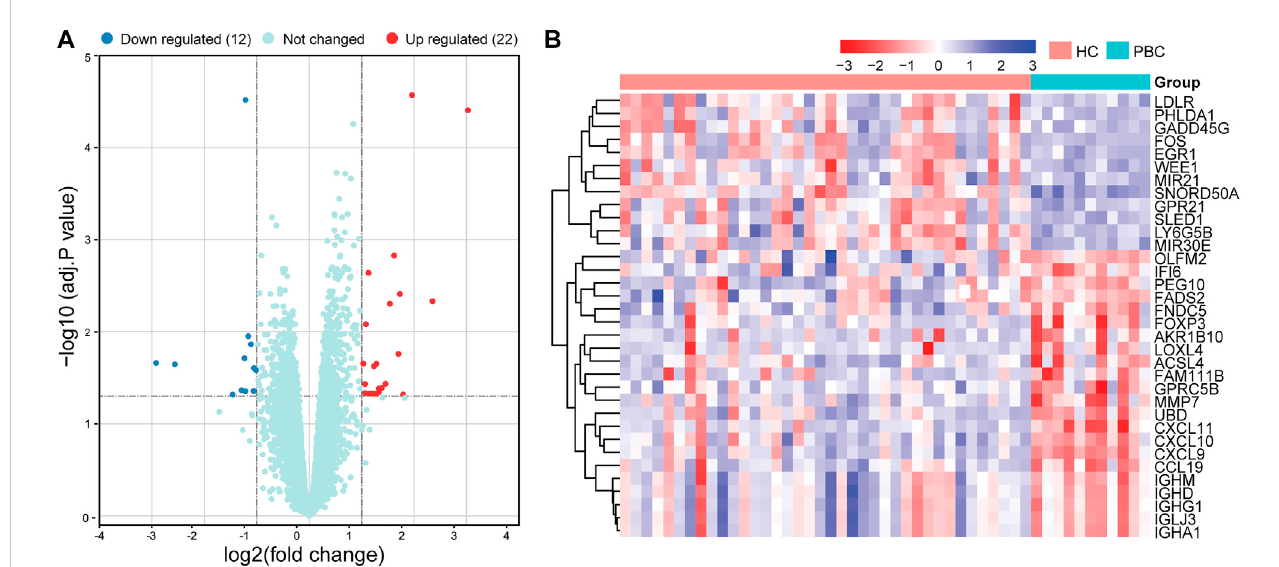
FIGURE 2 Volcano plot and heatmap of DEGs in the datasets. (A) Volcano map of all DEGs in GSE61260 analyzed using the limma package in R. Adjusted p -value < .05 and | log2 FC | ≥ 1 were considered threshold values of signi fi cant DEGs. (B) Heatmap of DEGs, including 22 up- and 12 downregulated genes. DEGs, differentially expressed genes; PBC, Primary biliary cholangitis; HC, healthy